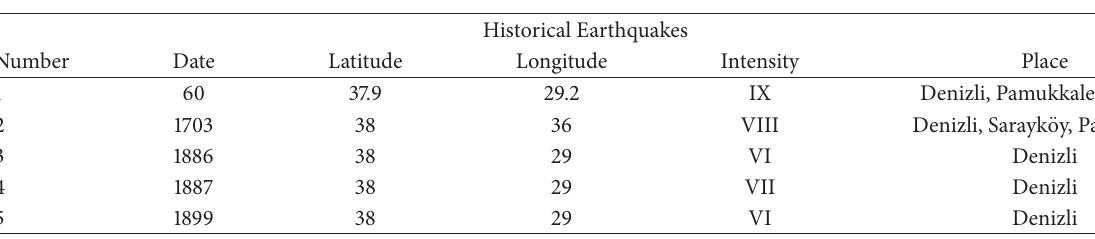
Table 1: Historical and instrumental earthquakes ( 𝑀 > 4 ) around Denizli and its surrounding (Bo˘gazic¸i University, Kandilli Observatory and Earthquake Research